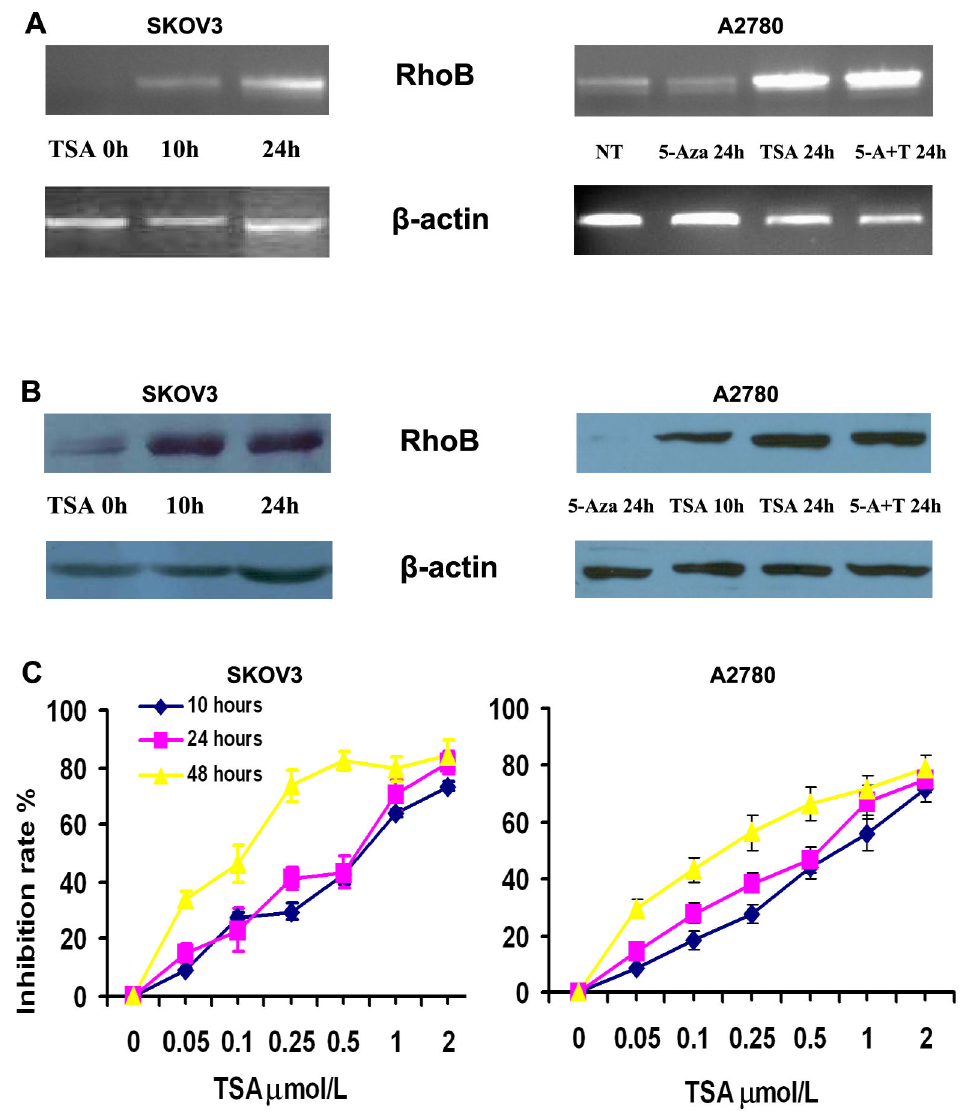
Figure 3. Restoration of expression loss of RhoB gene. Regulation of RhoB expression loss by histone deacetylase (HDAC) inhibitor trichostatin (TSA) and methyltransferase inhibitor 5-Azacytidine (5-Aza). ( A ) Semi-quantitative RT-PCR analysis of RhoB expression levels in ovary carcinoma cell : Cells were either nutreated (NT), treated with 5-Aza at 2 μM, with TSA at 0.5 μM, or with combination of TSA (0.5 μM) and 5-Aza (2 μM). It can be seen that 5-Aza did not increase RhoB expression. However, TSA could significantly reverse RhoB silencing in ovary cancer SKOV3 and A2780 cells. β-Actin was used as inner control. ( B ) The expression confirmation of RhoB by Western blotting analysis : SKOV3 and A2780 cells were exposed to 0.5μM TSA at different time points. β-actin was used as equal loading control. As shown, TSA treatment, but not 5-Aza, revived the protein expression of RhoB. ( C ) TSA-mediated cell growth arrests of ovary cancer cells : SKOV3 and A2780 cells were treated with gradient TSA for 10, 24 and 48 hours. The inhibition rate was calculated as a percentage of the in vitro proliferation in terms of untreated control cells by MTT. TSA inhibits SKOV3 and A2780 cells growth in a concentration- and time-dependent manner. The results were expressed as mean±S.D. doi: 10.1371/journal.pone.0078417.g003 with a parallel increase in the RhoB level. Huelsenbeck et al. bacterial toxins such as Clostridium difficile toxin B (TcdB). The demonstrated that the apoptotic effect of TcdB was mediated cells treated with 1 ng/ml of TcdB, the RhoA level decreases by RhoB [43].